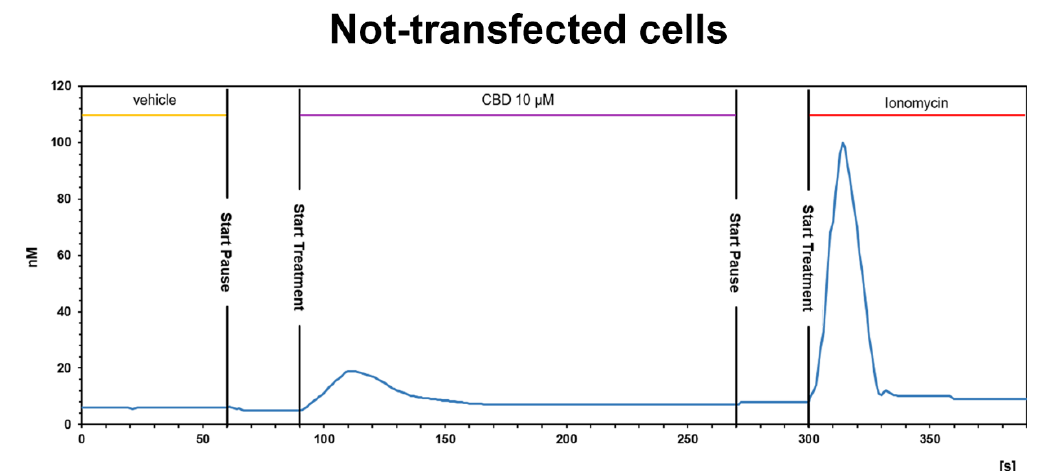
Figure 6. CBD induces a slight [Ca 2+ ] i increase in not-transfected CHO cells. Representative traces of single-cell [Ca 2+ ] i response in Fura-2- loaded not-transfected CHO cells. Ionomycin (2 μ M) was added at the end of the experiment. Images, collected continuously for 390 s, were analyzed by the Leica MetaMorph software for calcium imaging to quantify the intracellular [Ca 2+ ] i increase expressed as 340/387 nm excitation ratio between calcium-bound Fura-2 (green cells) and calcium-free Fura-2 (red cells).